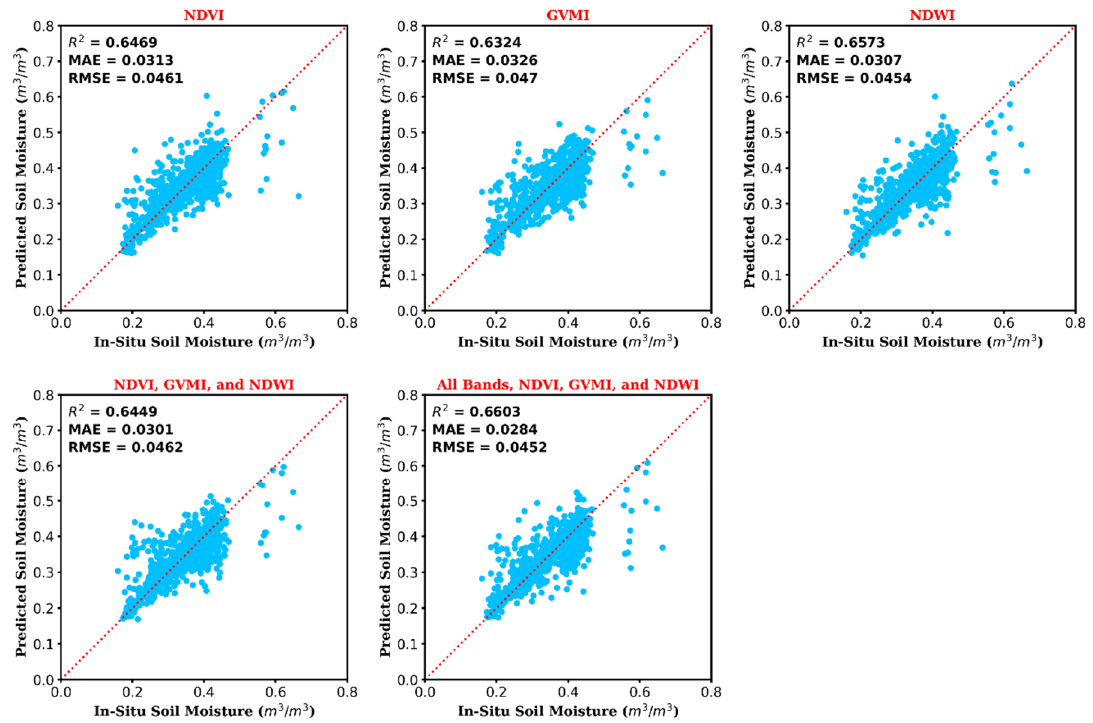
Figure 4. Results of using NDVI, GVMI, and NDWI as input data to the CNN architecture